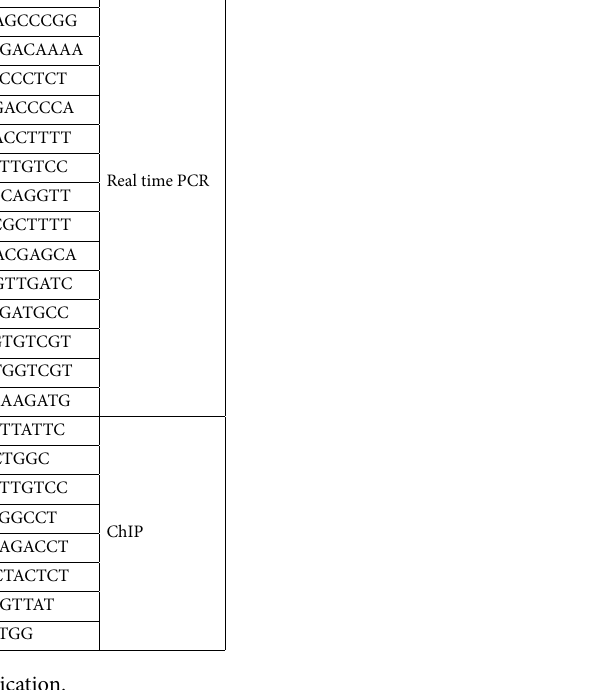
Table 1. Primer sequences and